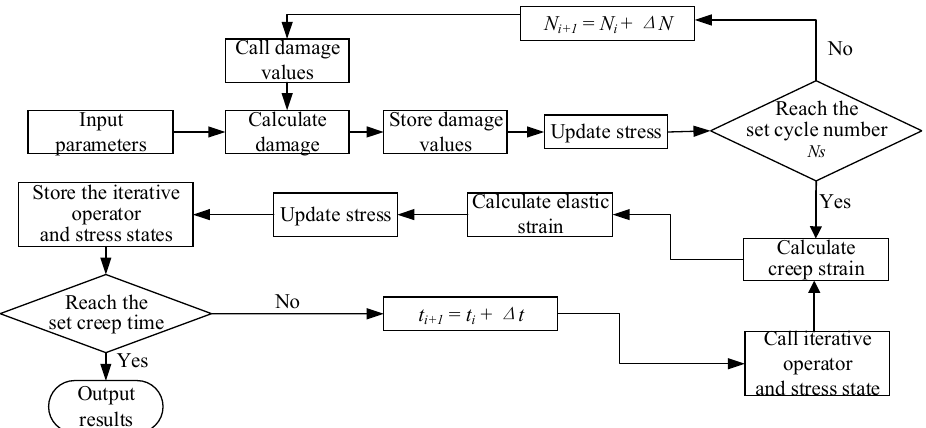
Figure 2. The flow chart for subroutine USERMAT: N i denotes the number of cycles, N i+1 means the number of cycles after increase, N Δ indicates cycle increment, t i represents time, t i+1 is the time after increase, and t Δ denotes time increment.